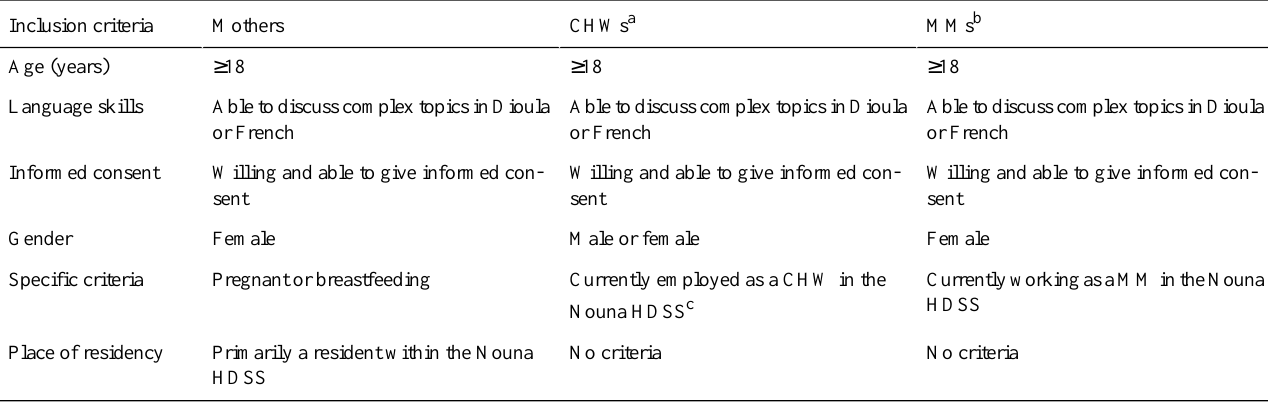
Table 3. Inclusion criteria (exclusion criteria are the inverse of the inclusion